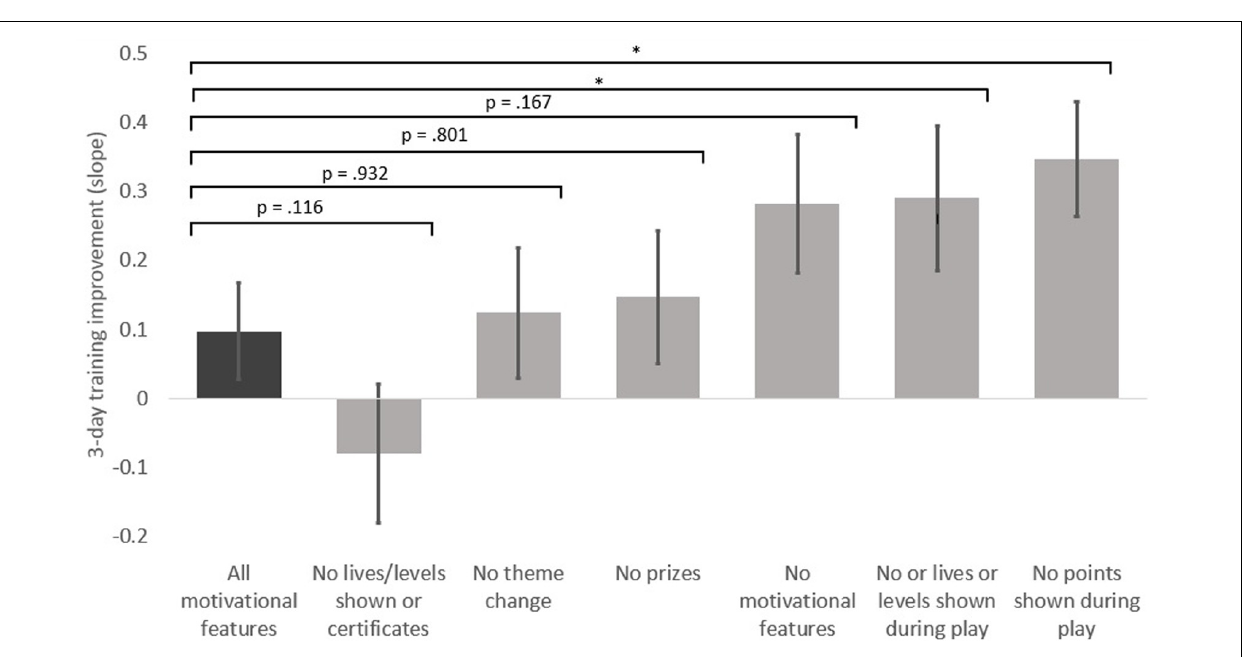
split of students by age revealed that students 10 and under ( N = 47, mean = 3.75, SD = 0.79) were significantly more excited to complete the task than students 11 and older ( N =